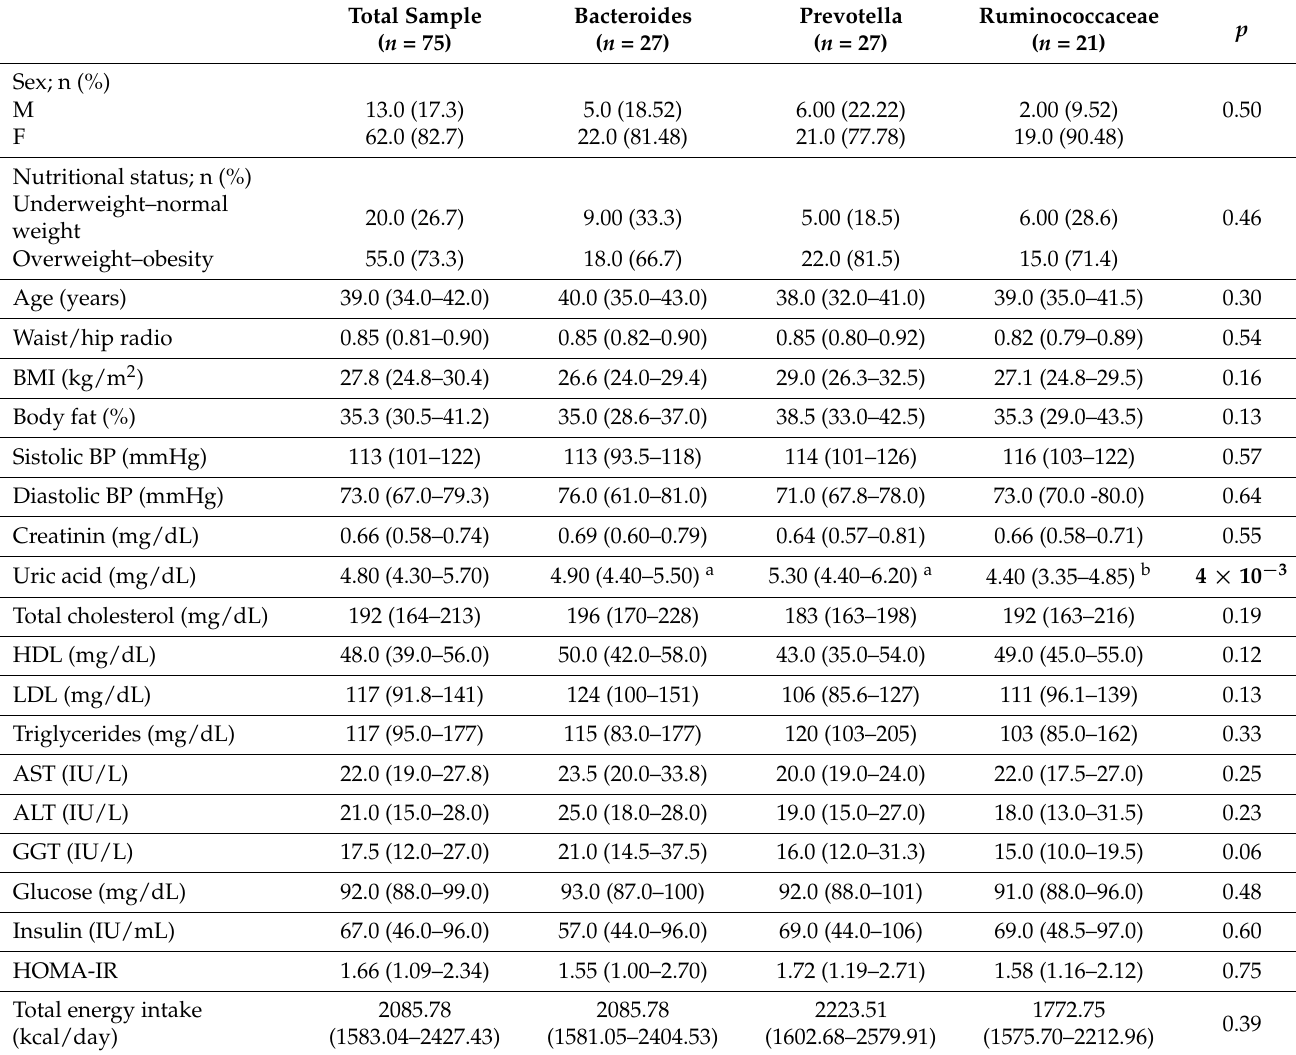
Table 2. Characteristics of adults included in the